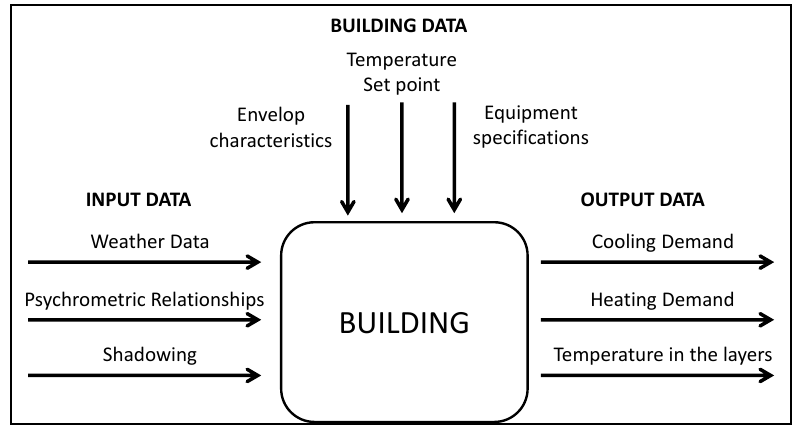
Figure 13. Parameters of TRNSYS Model.